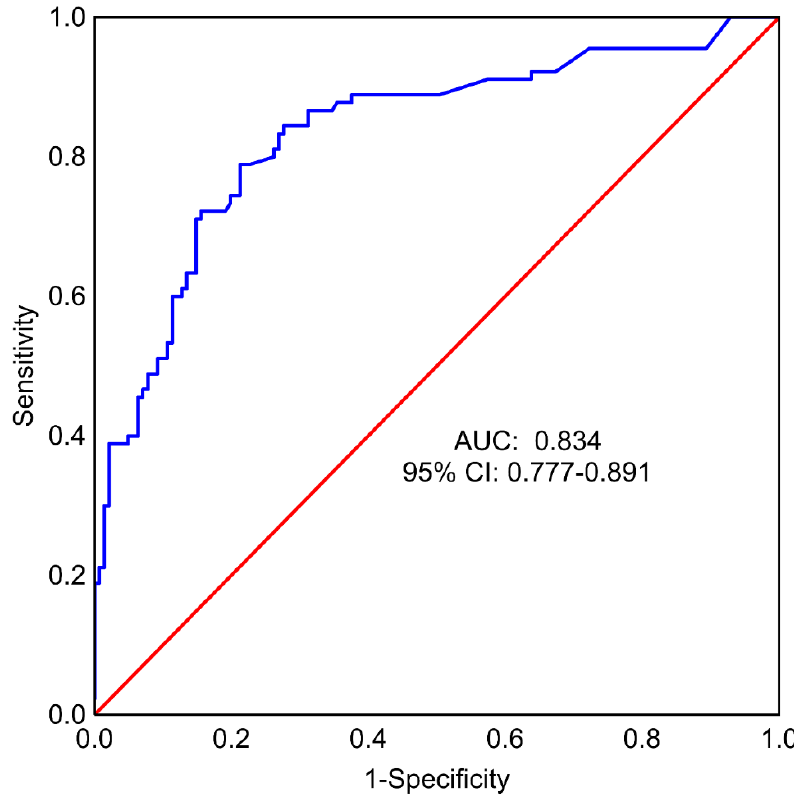
Figure 3. Receiver operating characteristic (ROC) curve for multivariate model built using backward feature selection for predicting minor and major complications following breast reconstruction surgery. AUC—area under the ROC curve, 95% CI − 95% confidence interval. Confidence intervals were calculated using formula by Hanley and McNeil. Model quality assessment using the ROC curve.